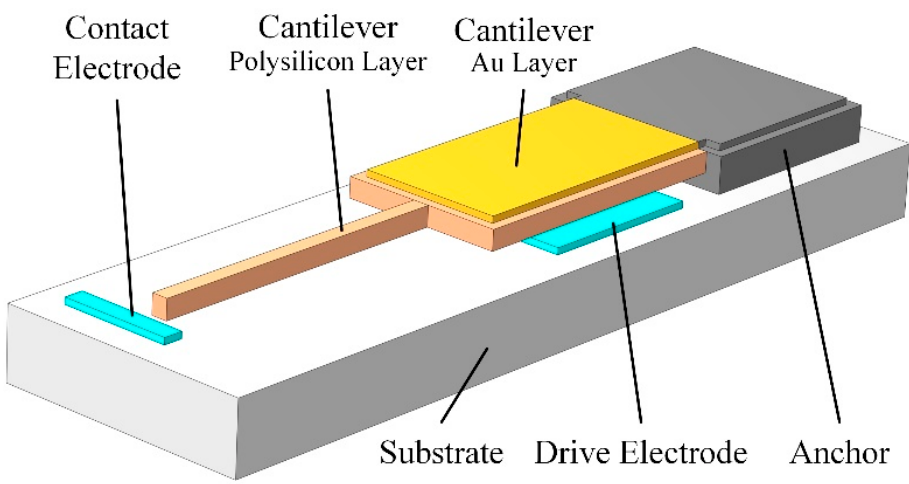
Figure 1. Schematic diagram of a test structure.